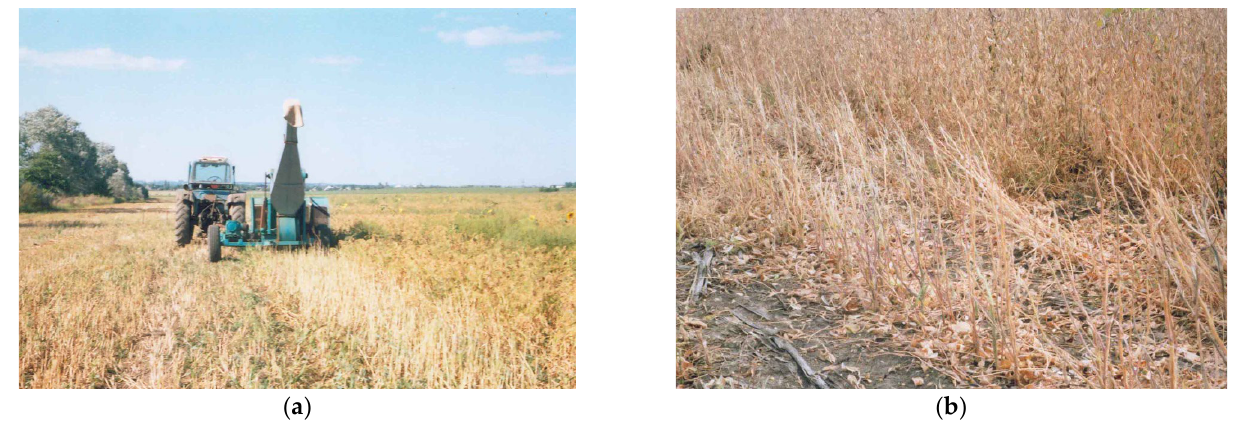
Figure 3. View of the field after the passage of the harvesting machine with combing working units: ( a ) millet field, ( b ) soybean field.